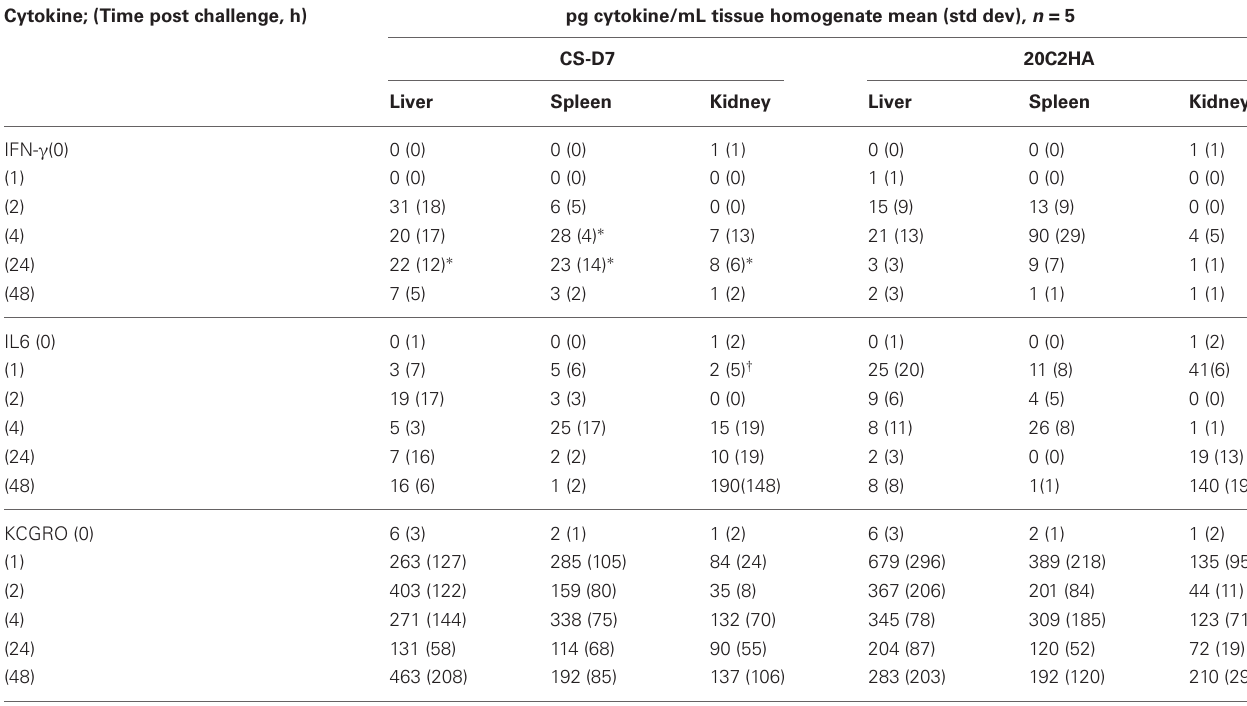
∗ Comparison of IFN- γ concentrations between mice treated with CS-D7 and mice treated with 20C2HA; Spleen at 4h: P = 0.002; Spleen at 24h: P = 0.076; Liver at 24h: P = 0.008; Kidney at 24h: 0.05.